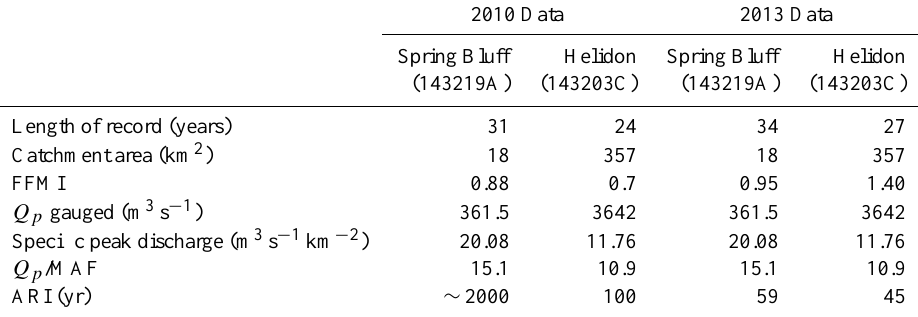
Table 1. Flood characteristics of the 2011 flood, showing calculated flash flood magnitude index (FFMI; standard deviation of the log 10 of the annual maximum series) and the average recurrence interval (ARI) for the 2011 event for data up to 2010 and 2013 inclusive; 2010 values from Thompson and Croke (2013). Q p : maximum recorded flow; MAF: mean annual flow. See Fig. 2 for gauge